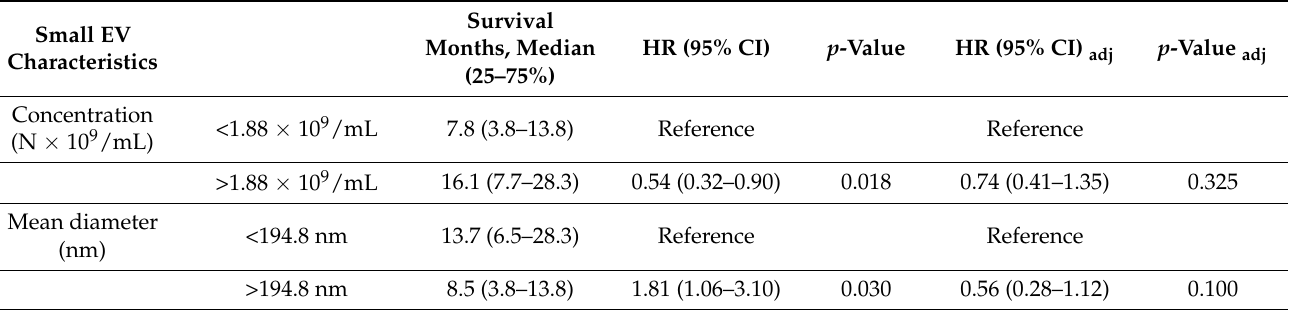
Table 4. Association of sEV characteristics before surgery with OS after surgery using stratification based on ROC curve analysis.